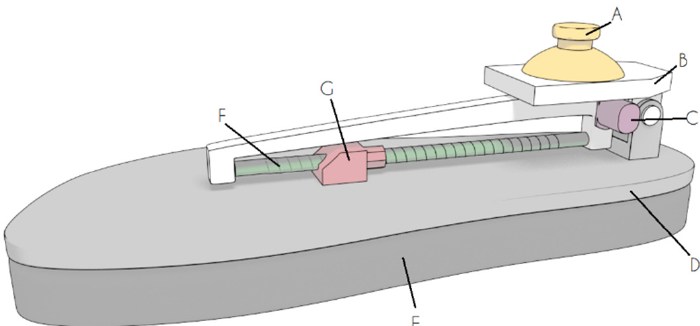
Figure 12. LPP active prosthesis. Figure 13. CAS Prosthesis.